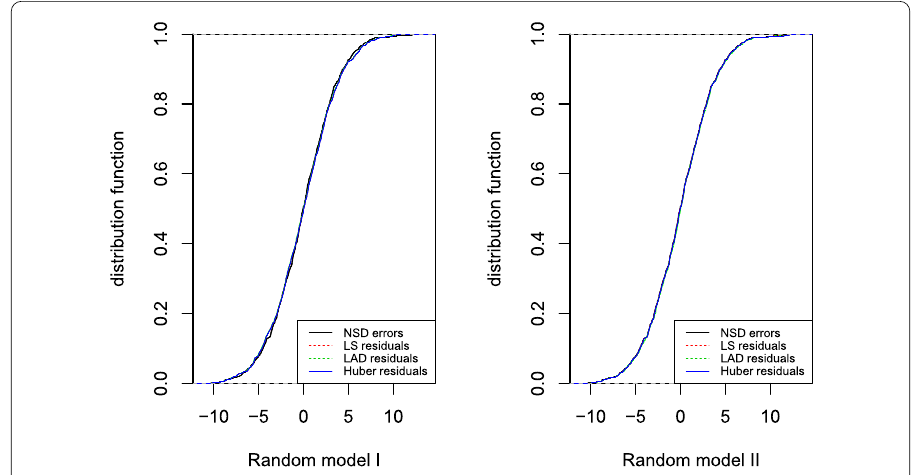
Figure 3 A comparison fitted distribution functions of residuals and assumed NSD errors (sample size is n = 1,000).